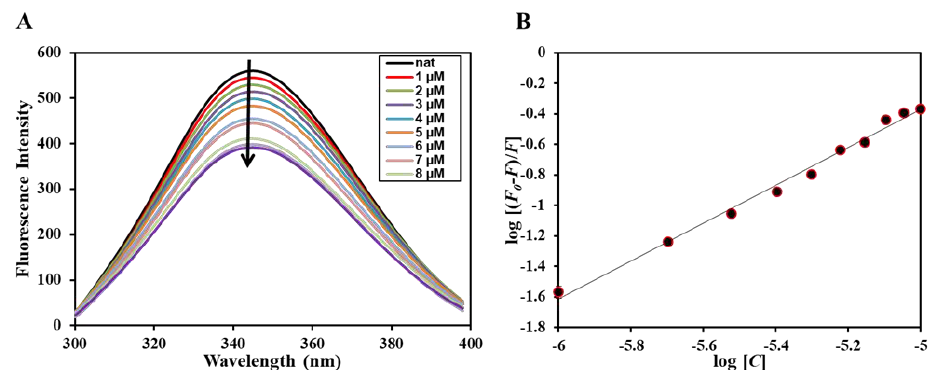
Figure 7. ( A ) Fluorescence emission spectra of MARK4 in the absence and presence of different Mtf concentration (0 – 10 µM). The protein was excited at 280 nm with emission recorded in the range of 300 – 400 nm. ( B ) MSV plot obtained for binding of Mtf with MARK4. 300–400 nm. ( B ) MSV plot obtained for binding of Mtf with MARK4.